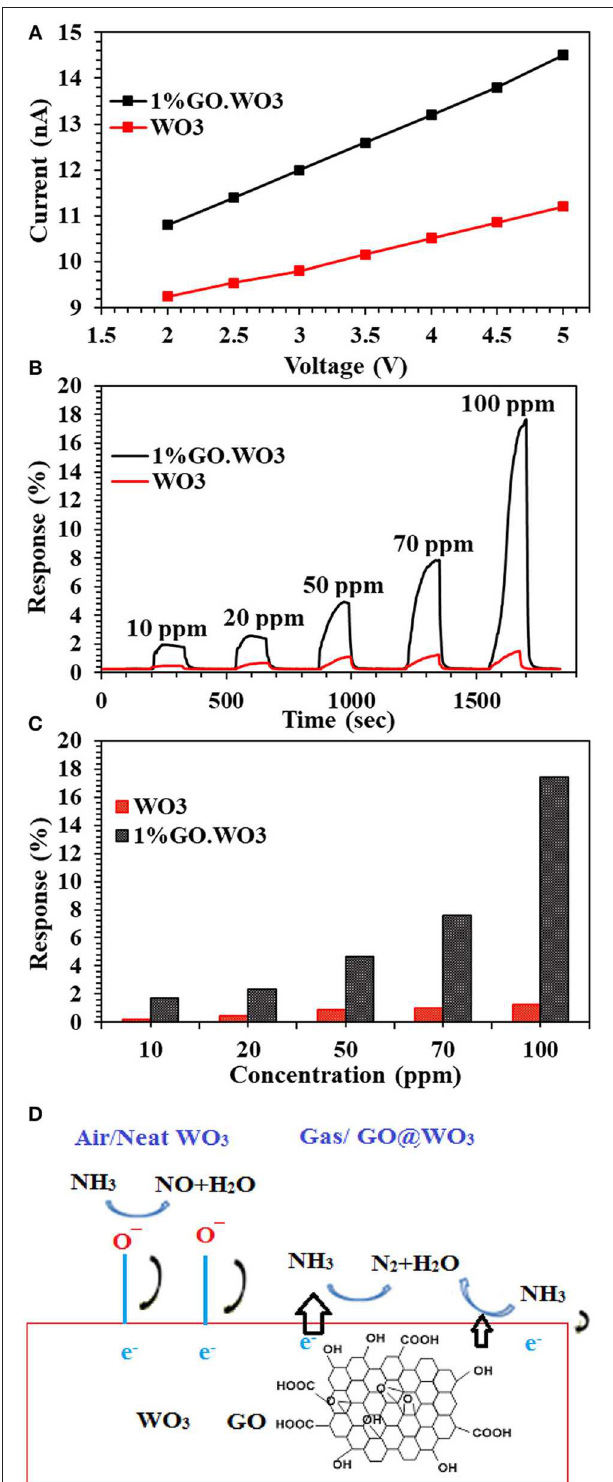
FIGURE 8 | I-V characteristic curves of WO 3 and 1%GO.WO 3 catalysts (A) , and their response transient to different ammonia concentration (10–100 ppm) at 200 o C (B) response Vs. NH 3 concentration for WO 3 and 1 % GO.WO 3 (C) beside the mechanism of NH 3 gas sensing on the 1%GO.WO 3 catalyst (D)